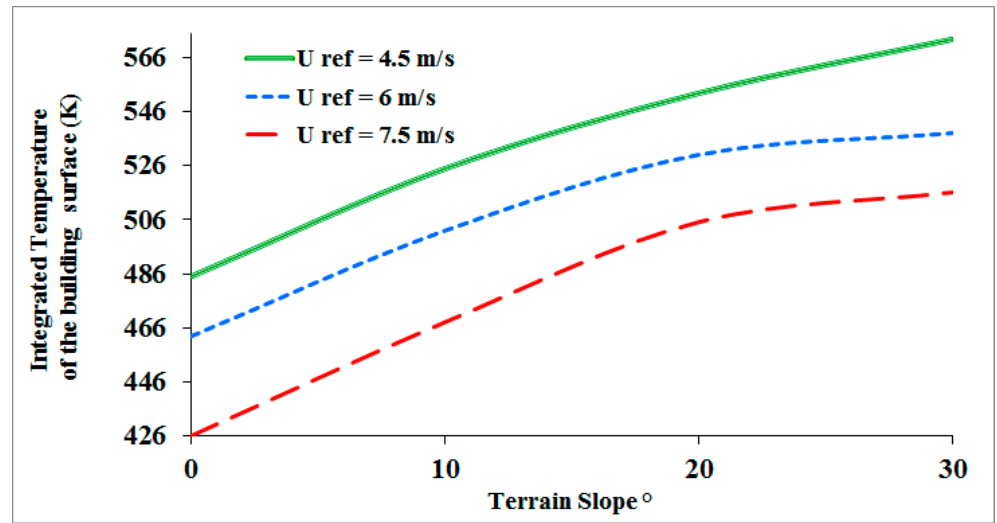
Figure 12. Integrated temperature on the building surface for U ref = 4.5, 6, and 7.5 m/s and terrain slope 0 ◦ , 10 ◦ , 20 ◦ , and 30 ◦